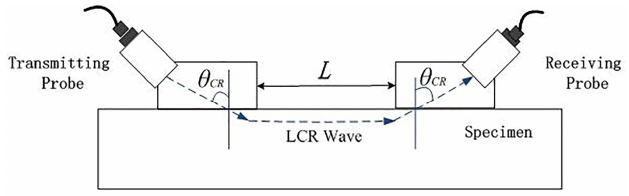
Figure 2. The schematic diagram of transmitting and receiving an LCR wave.